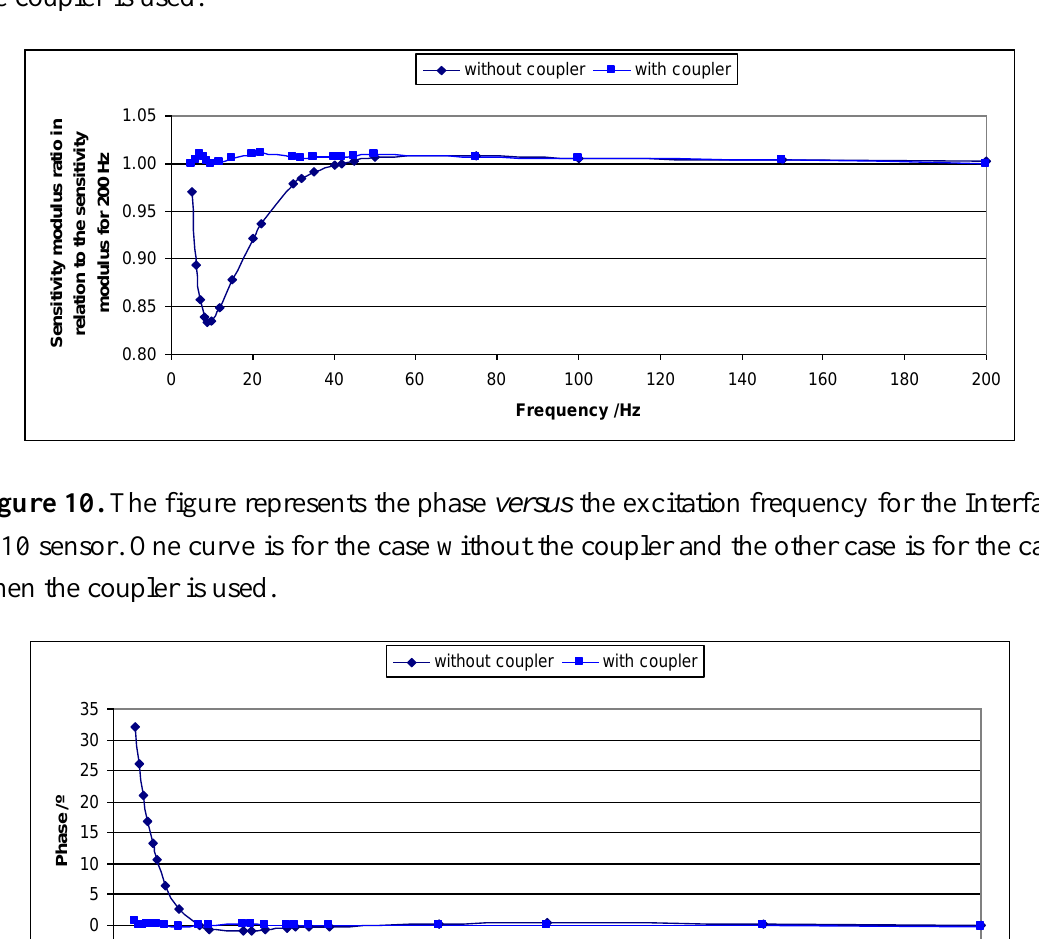
Figure 9. The figure represents the ratio between the sensitivity modulus and the sensitivity modulus for 200 Hz versus the excitation frequency for the Interface 1610 sensor. One curve is for the case without the coupler and the other curve is the case when the coupler is used.